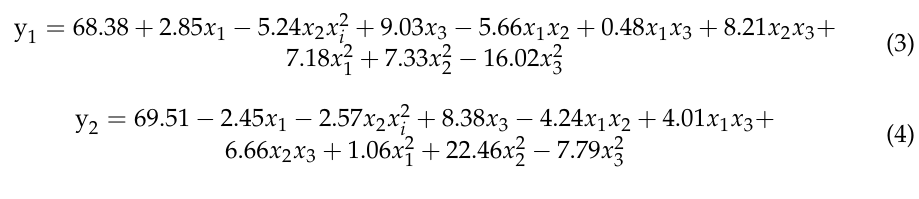
Table 2. Experimental design matrix and the results for removal percentage of PAHs and COD. Factors x 1 No